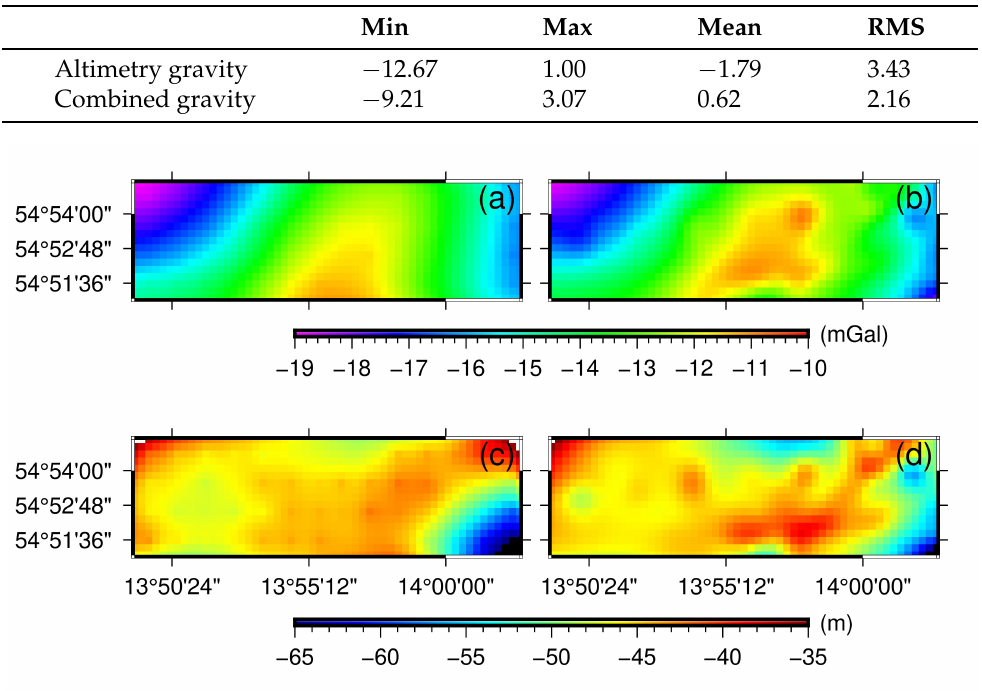
Table A1. Seafloor topography differences at the checking points in the experimental area (unit: m).